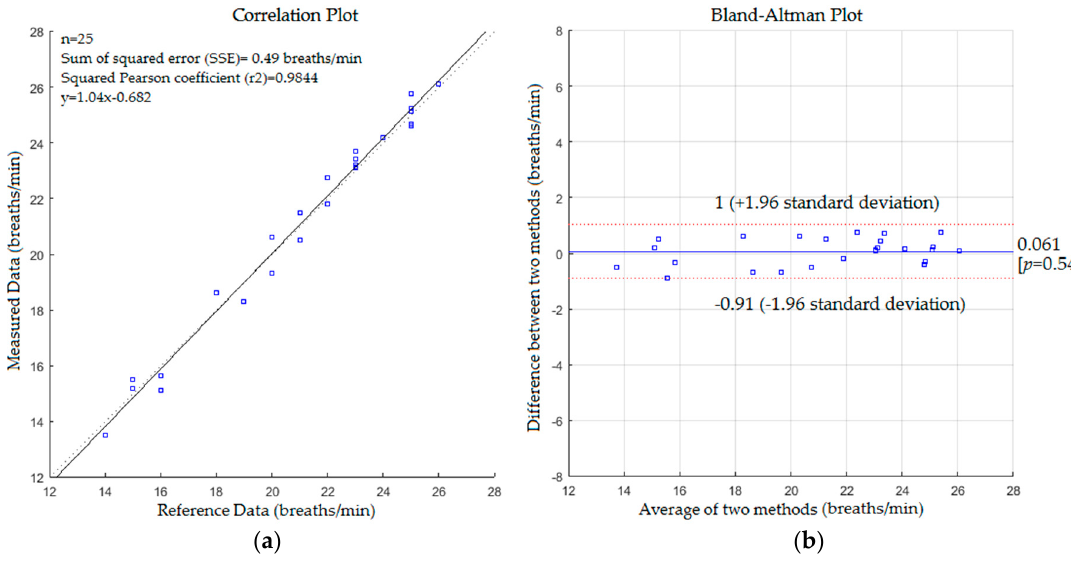
Figure 9. ( a ) Correlation plot; ( b ) Bland-Altman plot of the difference between measured data and reference data (first scenario without a blanket).